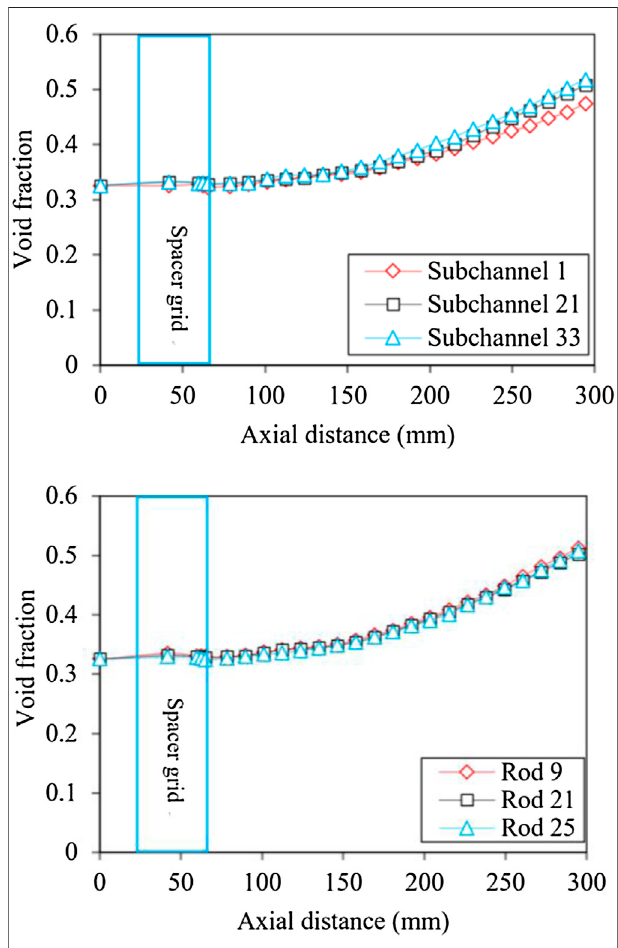
FIGURE7| Averagevoidfractionalongaxialdirectioninthesub-channel and around the fuel rod.